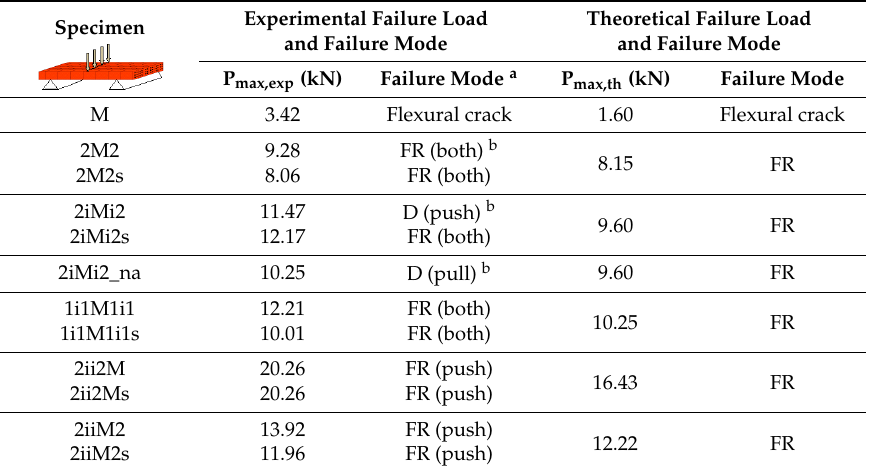
Table 3. Summary of experimental failure loads and analytical predictions.